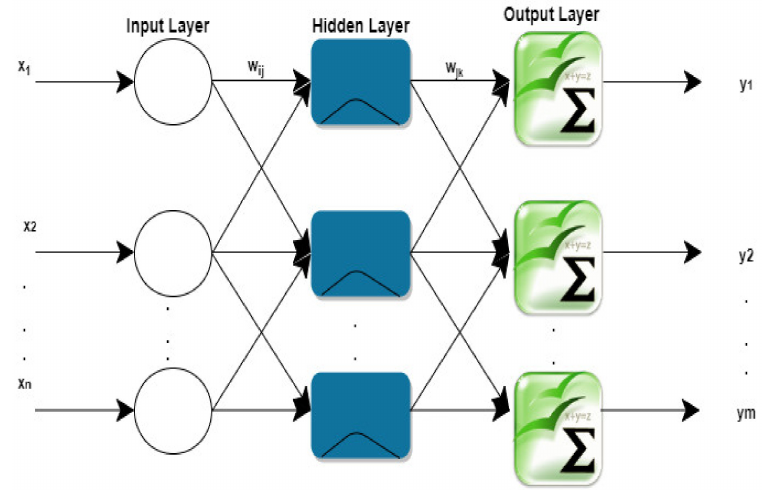
Figure 4. RBF network